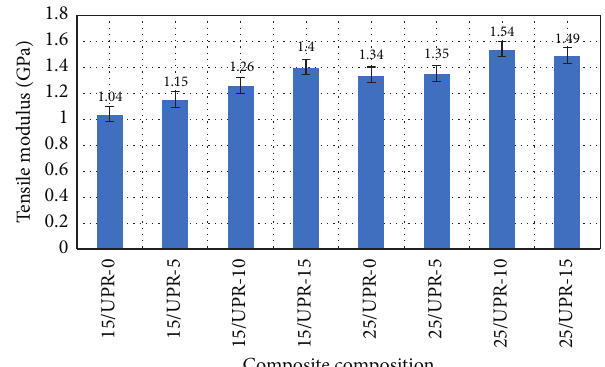
Figure 3: The variation of tensile modulus of the developed composite with changing the content of Al